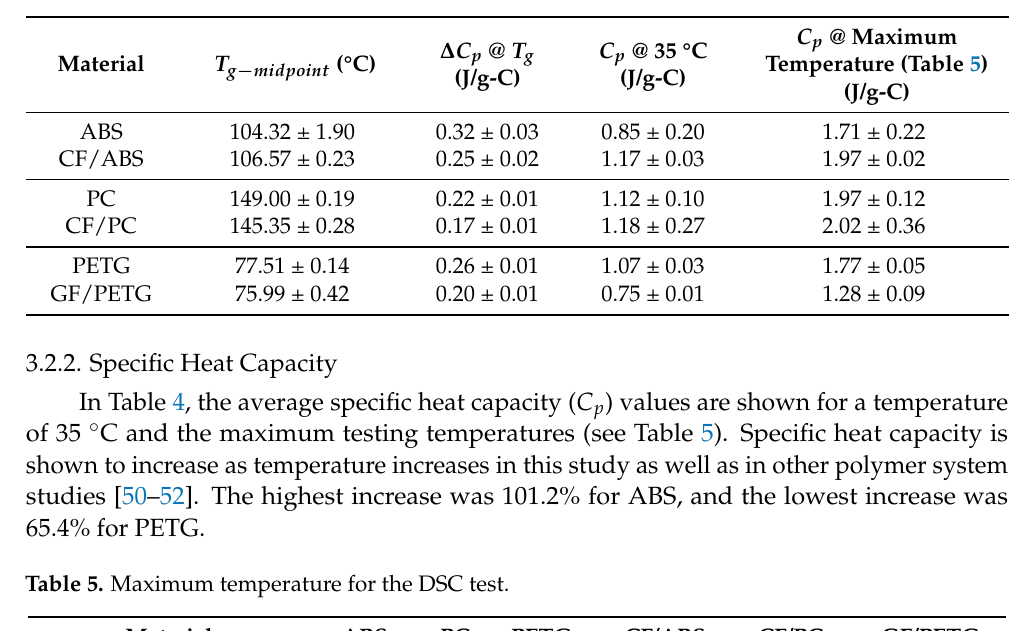
Table 4. Summary of T g and C p results. The T g was measured as the mid-point temperature ( T g midpoint ) of the normalized heat capacity versus temperature curve. The change in C p at the glass − transition region was also computed. C p values at a temperature of 35 ◦ C and at the test maximum temperature are displayed to show the temperature-dependence of C p .